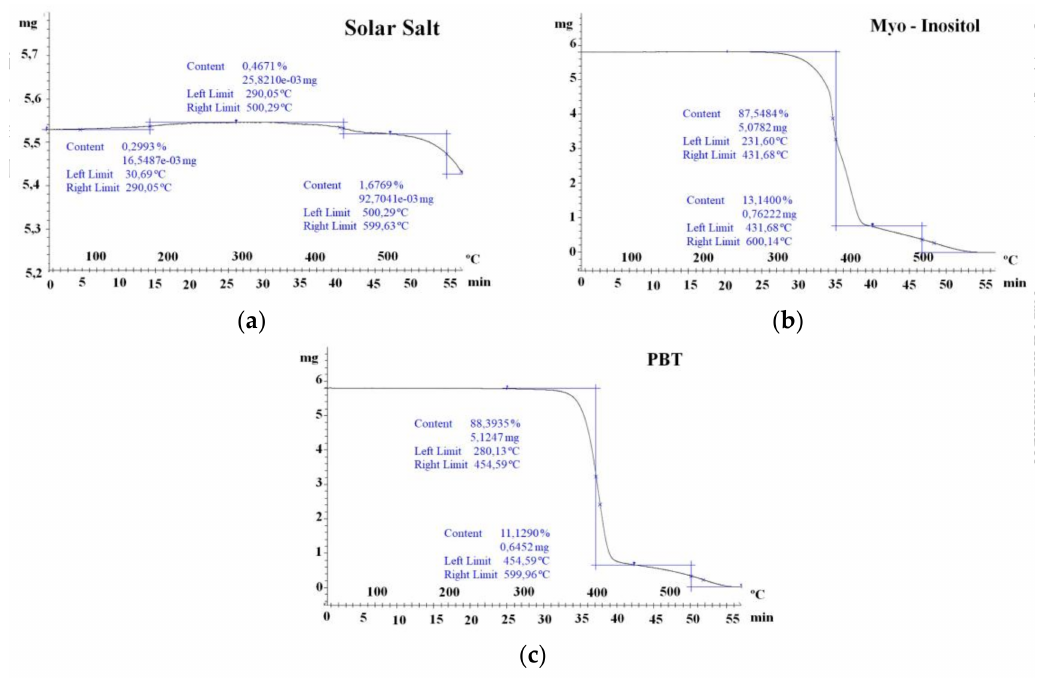
Figure 2. ( b ) myo-inositol, and ( c ) polybutylene terephthalate (PBT).